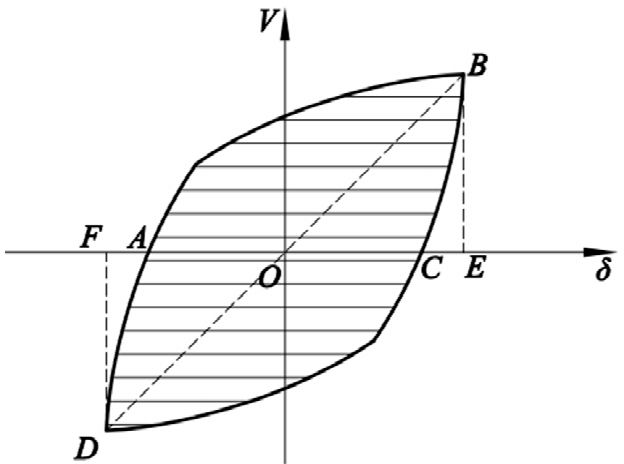
Figure 11. Definition of the energy dissipation Figure 11. De fi nition of the energy dissipation coe ffi cient.